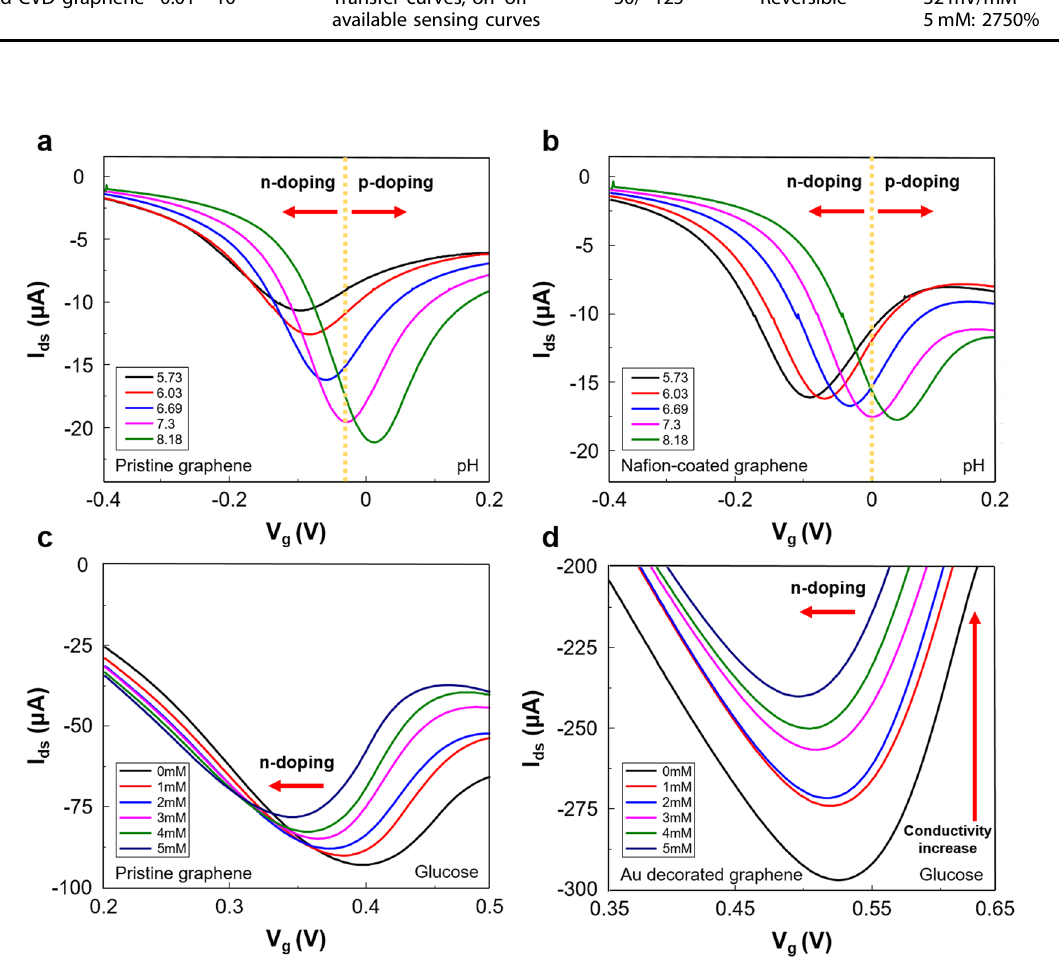
Fig. 5 Transfer characteristics of the graphene-based SFETs. pH transfer curves of a pristine graphene and b Na fi on-coated graphene ranging from pH 5.73 to 8.18. Glucose transfer curves of c pristine graphene and d Au-decorated graphene ranging from 0 to 5